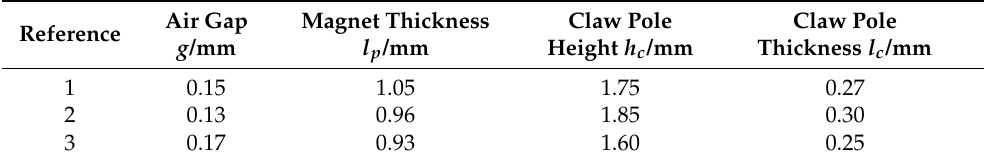
Table 2. Reference values of different factors.